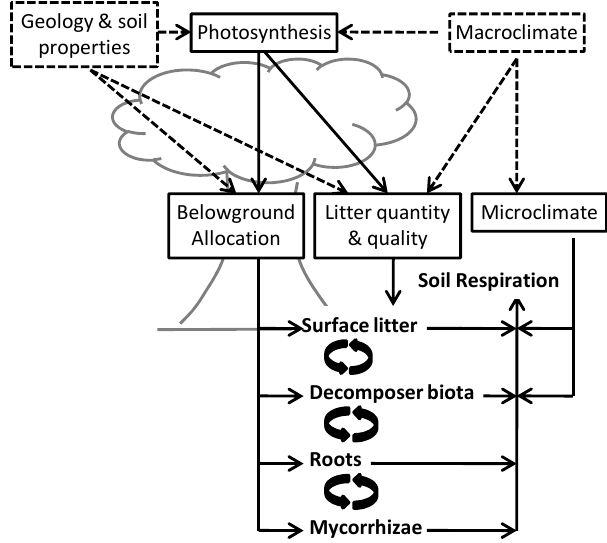
Figure 2) Key determinants of soil respiration. Dashed boxes and arrows indicate abiotic, indirect 1099 Fig. 2. Key determinants of soil respiration. Dashed boxes and factors and their pathways of influence on direct, plant mediated impacts denoted with solid 1100 arrows indicate abiotic, indirect factors and their pathways of influ- boxes and arrows. Bold text outside of boxes represents the principal contributors to soil 1101 ence on direct, plant mediated impacts denoted with solid boxes and respiration. 1102 arrows. Bold text outside of boxes represents the principal contrib- utors to soil